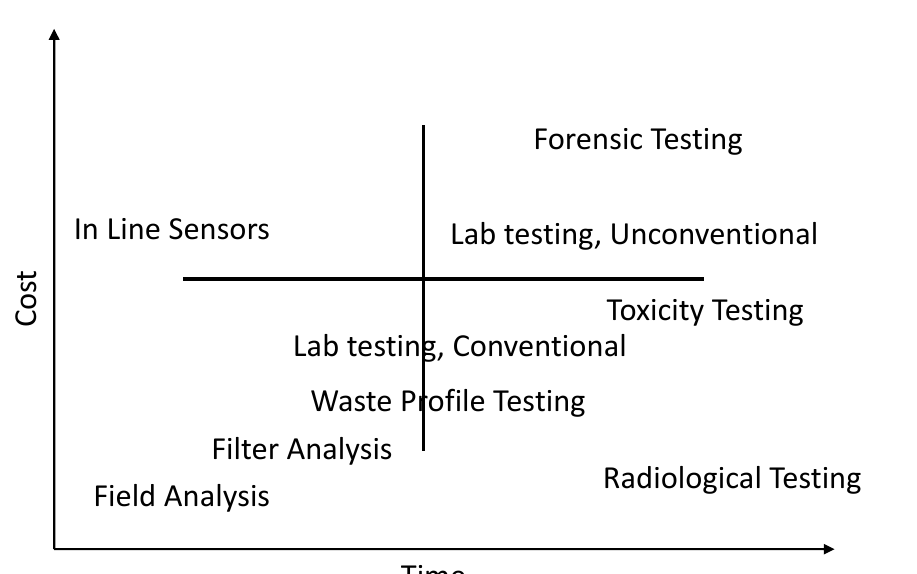
Figure 2. The cost and turnaround time of produced water analysis.